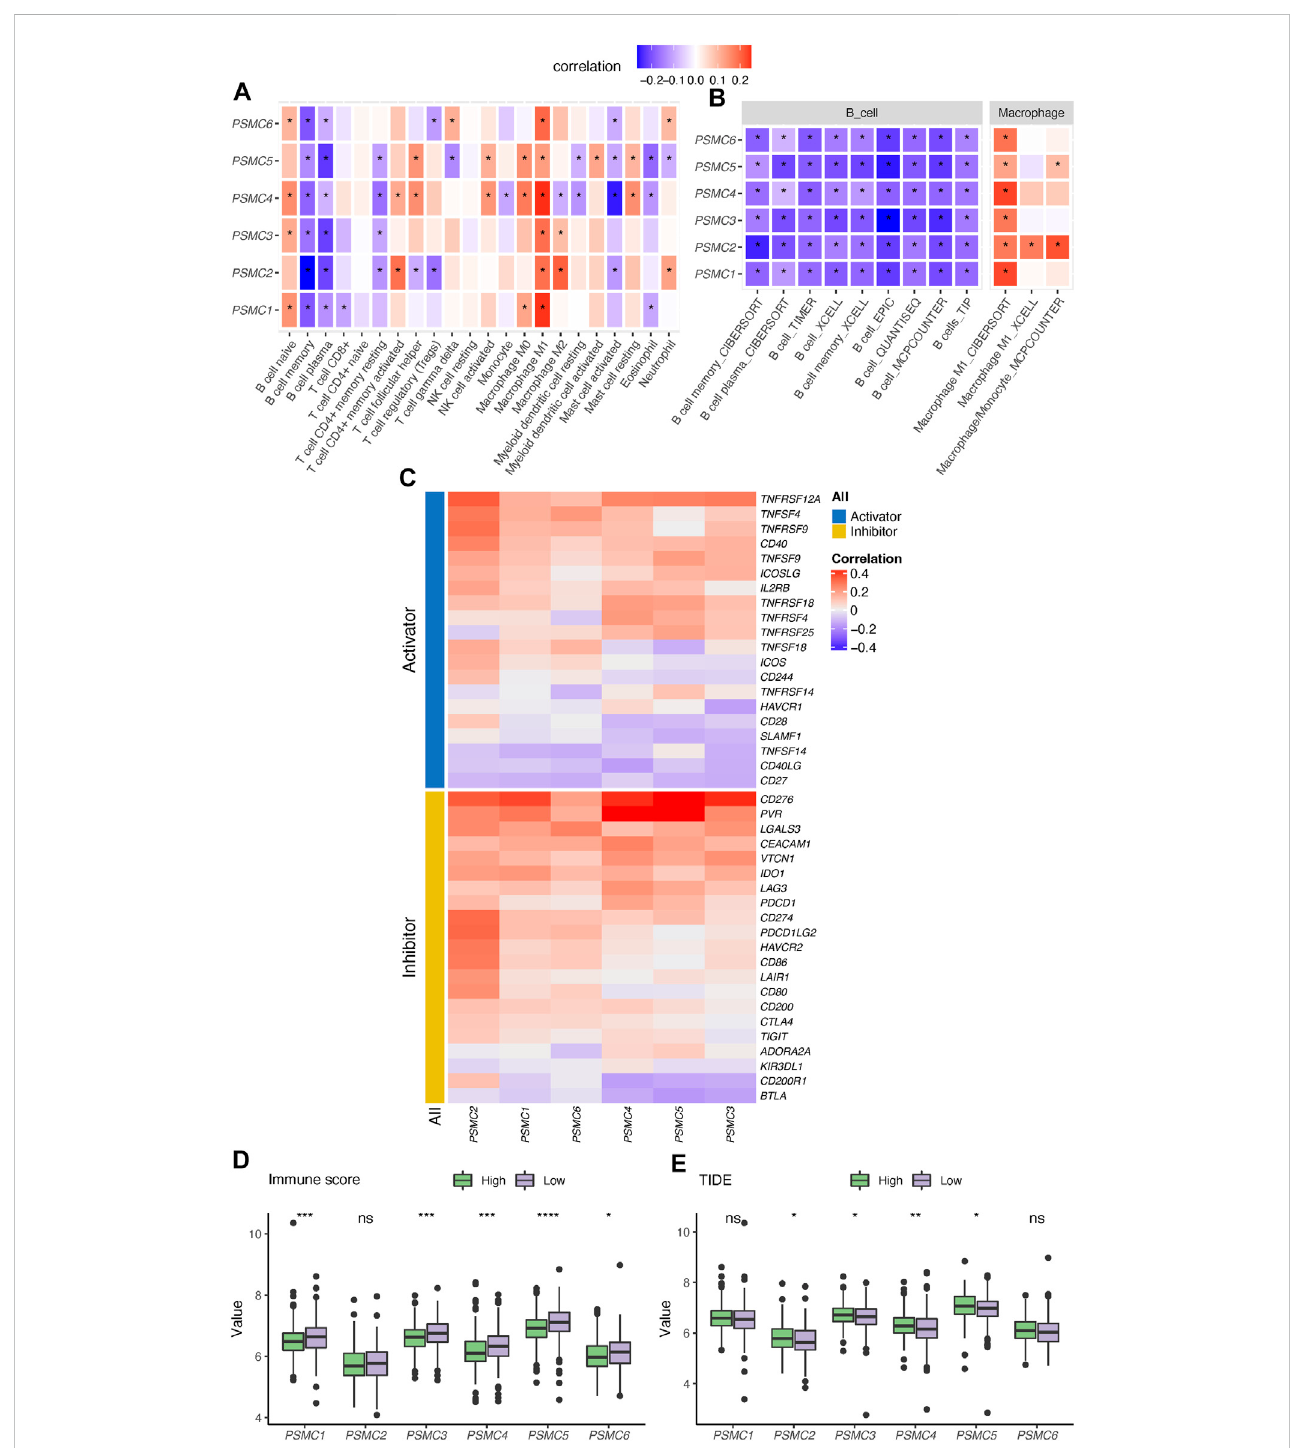
FIGURE 3 Correlation between PSMC genes and immune pro fi le in lung adenocarcinoma (LUAD). (A) Correlation analysis between PSMC genes and the tumor- in fi ltrated immune cell pro fi le in LUAD using the CIBERSOFT algorithm. (B) Correlation between the expression of PSMC genes and abundance of B cells and M1 macrophages revealed using multiple computational algorithms. (C) Correlation analysis between PSMC genes and immune checkpoints. Difference in the immune score (D) and T-cell dysfunction and exclusion (TIDE) (E) score between high- and low-expression groups. * p < .05, ** p < .01, *** p < .001, and **** p <